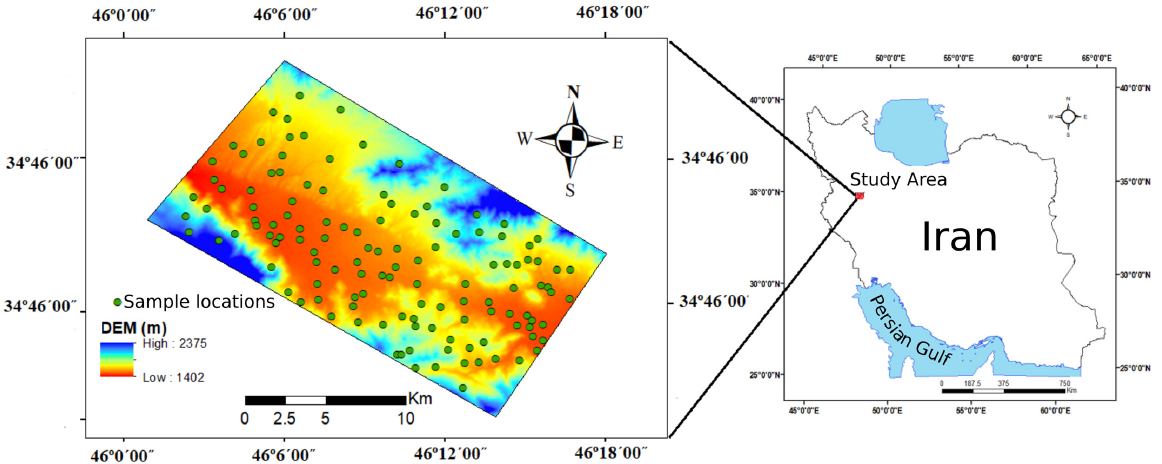
Figure 1. Location of the study area and collected soil